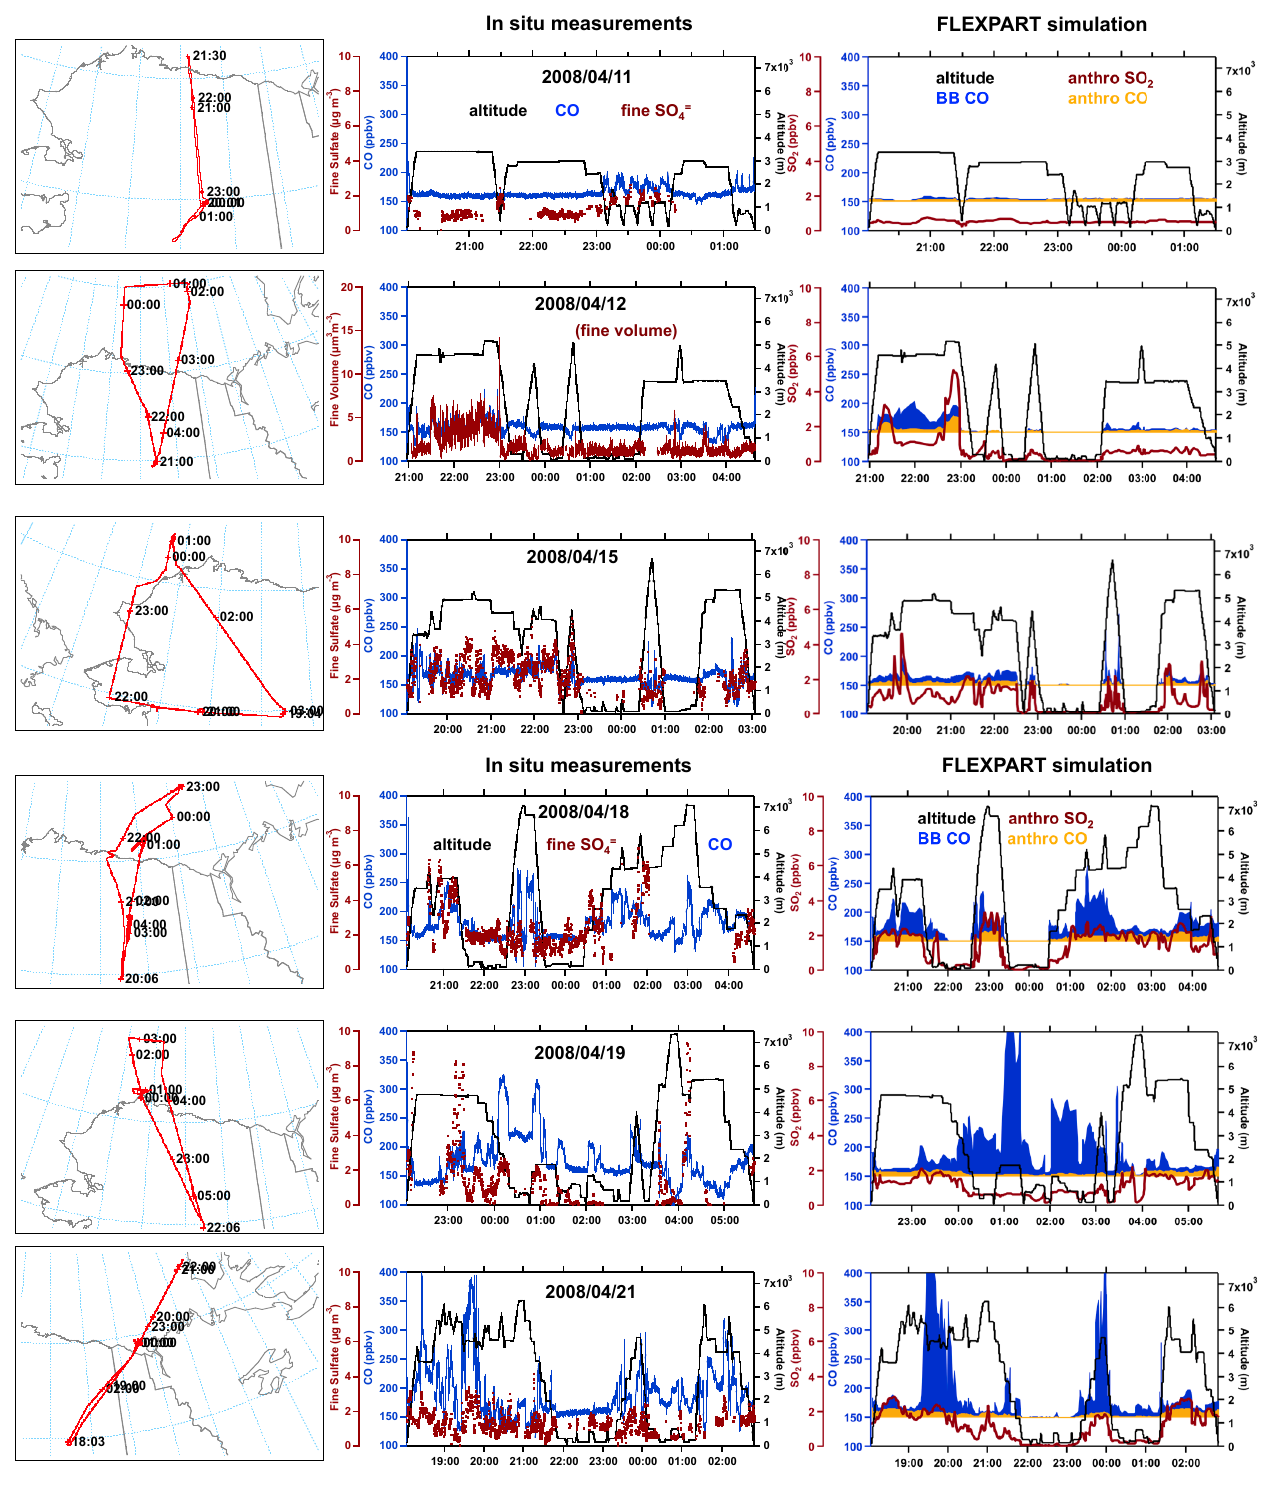
Fig. 2. Flight tracks (left column), in situ measurements (center column) and FLEXPART model simulations (right column) for all flights within Alaska during ARCPAC. Measured parameters are altitude, CO, and fine SO 4 = . (on 12 April 2008, the AMS instrument did not function and fine particle volume is shown.) Modeled parameters are anthropogenic SO 2 , CO from BB sources and CO from anthropogenic sources, including emissions within only the last 20 days. A 150ppbv offset is applied to CO values to represent background CO, which includes aged BB, anthropogenic, and biogenic